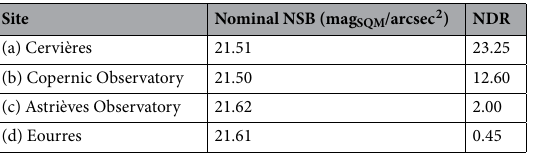
Table 2. Summary of the nominal NSB and NDR indicators of the 4 different sites.